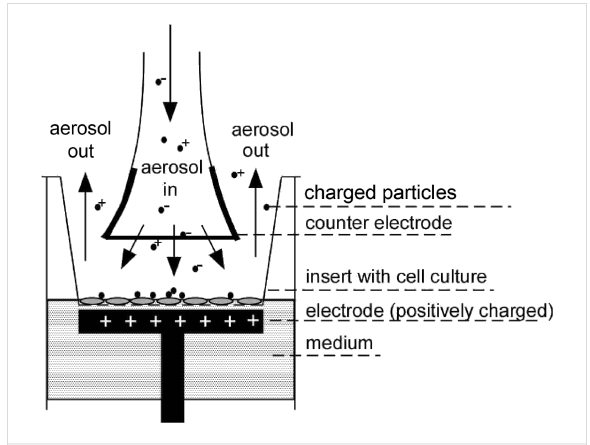
Figure 2: Schematic view of the Vitrocell ® exposure chamber modi- fied with an electrode for electrostatic particle deposition.